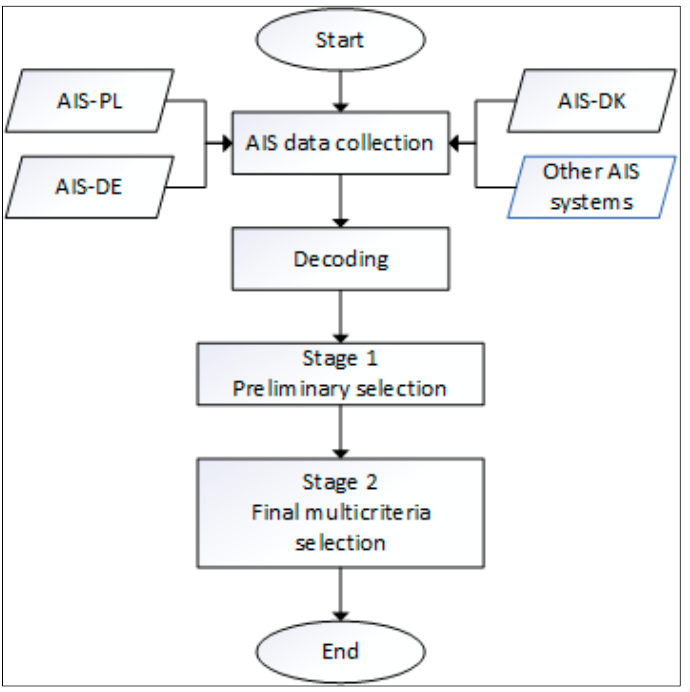
Figure 1. Algorithm for the selection of vessels for a SAR operation (authors’ own work).